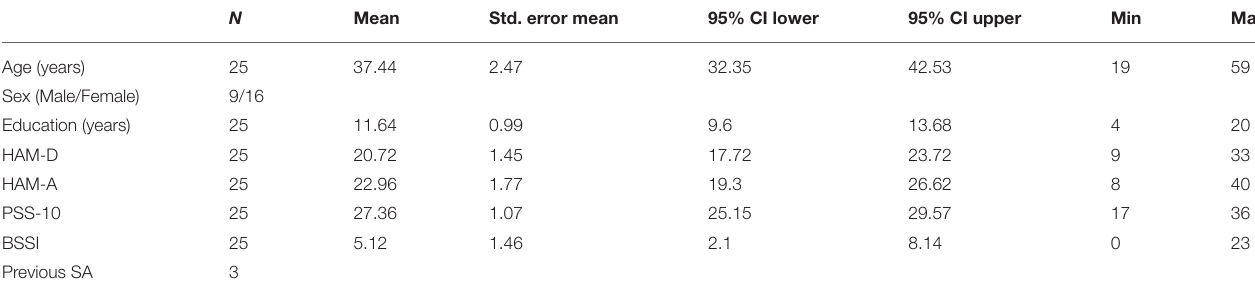
TABLE 1 | Demographic and psychological characterization of the sample.